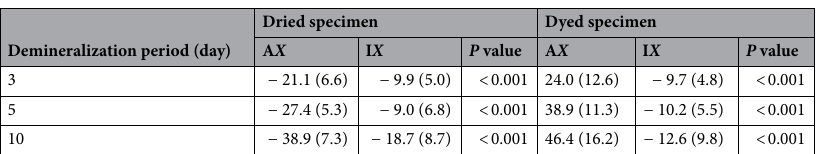
Demineralization period